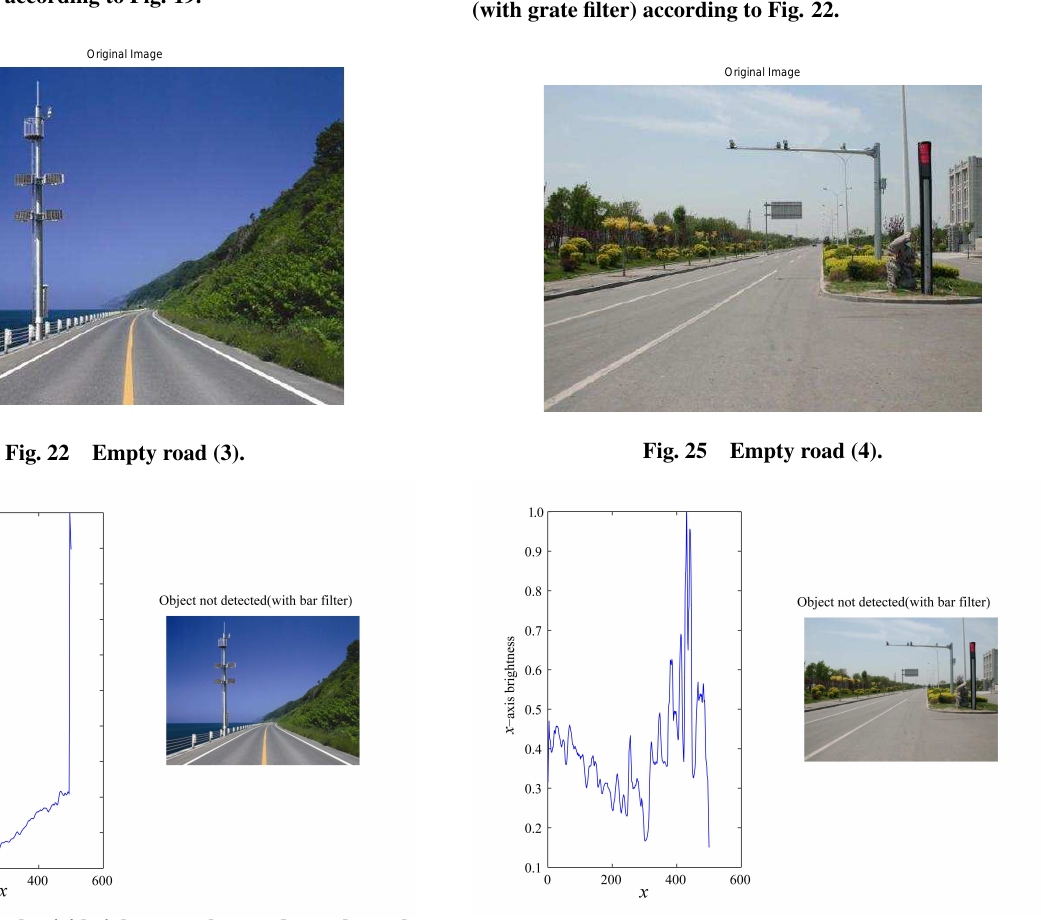
Fig. 26 Horizontal axis’ brightness values and search result (with bar filter) according to Fig.